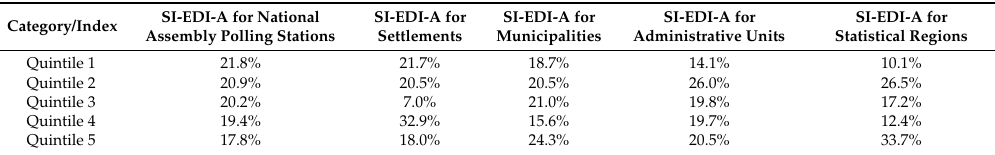
Table 4. Distribution of non-deprived people (quintiles 1 to 4, n = 1,386,432) according to the SI-EDI-I into the different quintiles of the ecological deprivation indices